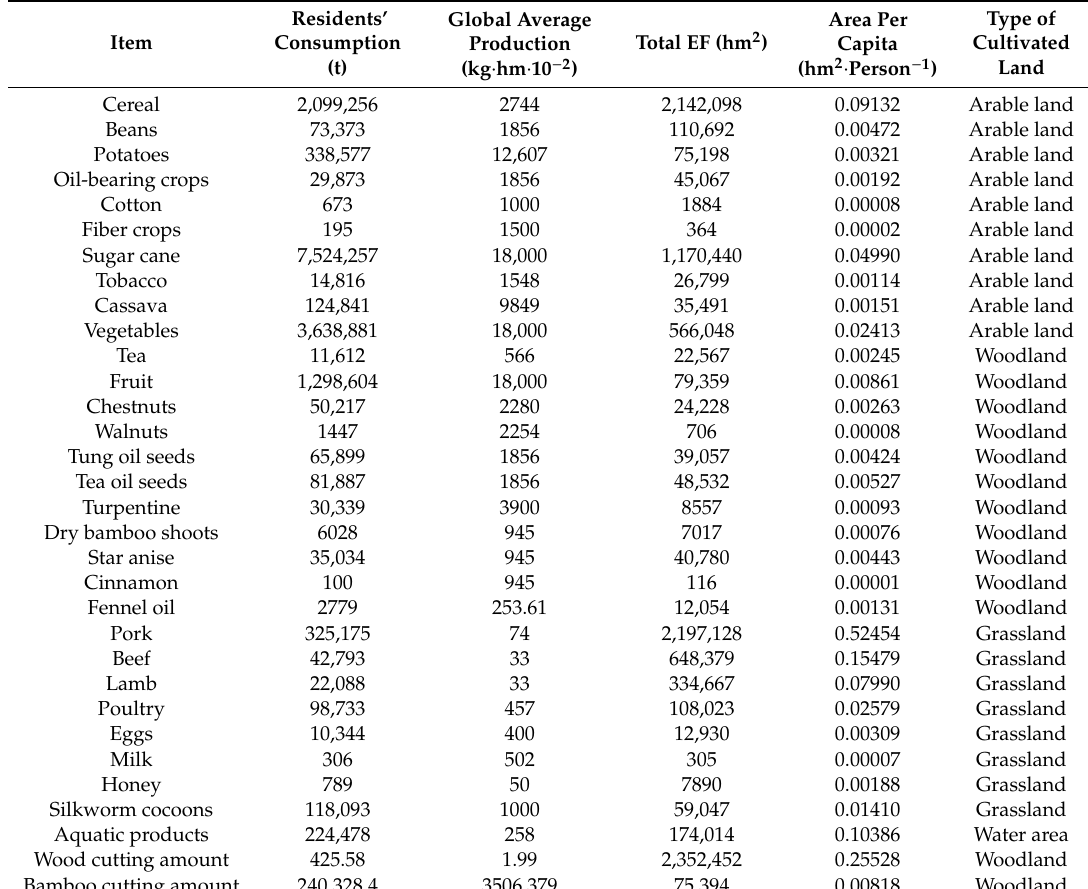
Table 2. Biological resources footprint account of northwestern Guangxi in